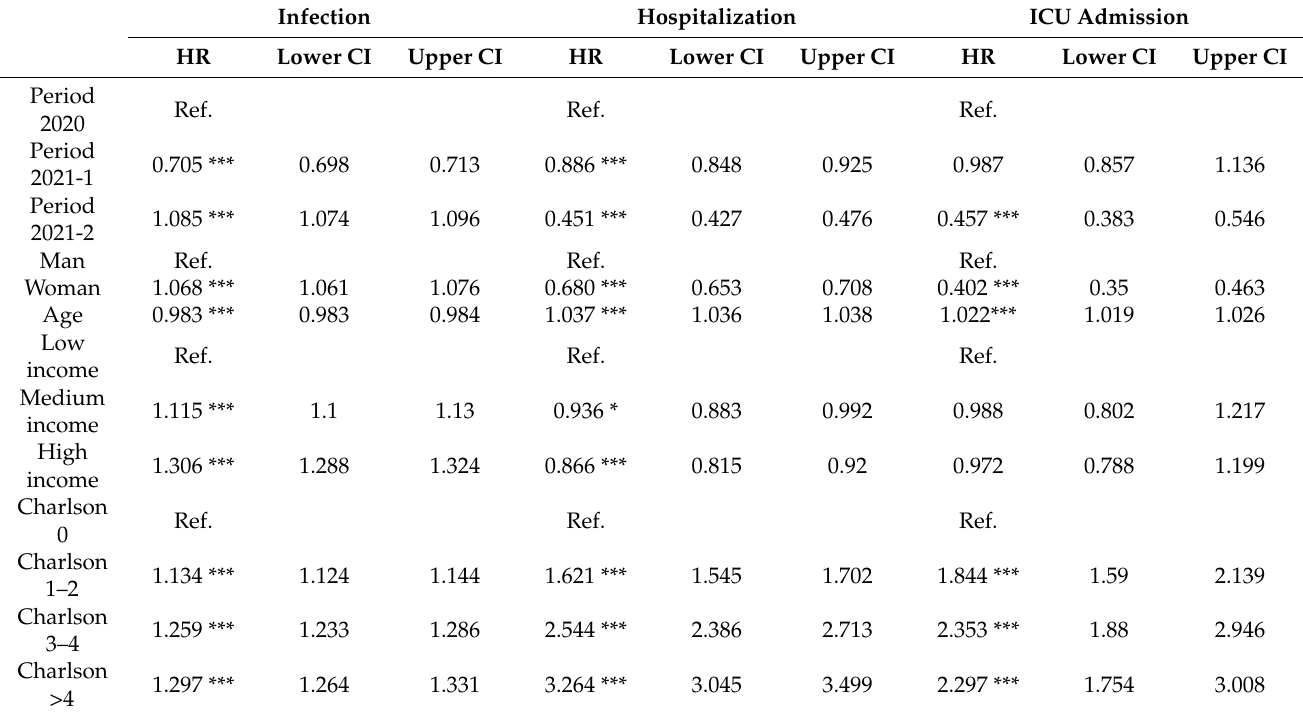
Table 4. Change in the adjusted risk of cases, hospitalizations, and ICU admissions in the three periods measured by hazard ratio (Cox regression) including the period as a